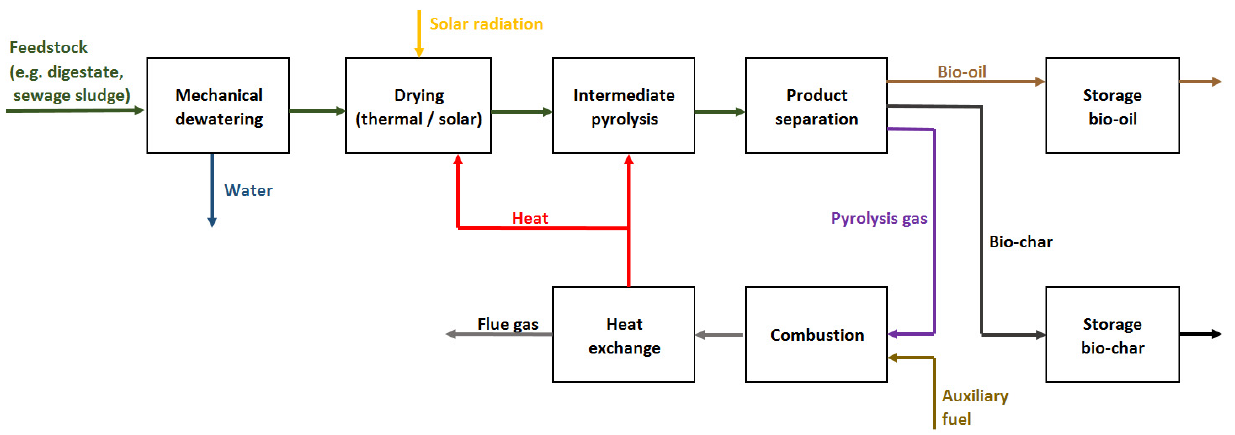
Figure 2. Intermediate pyrolysis process